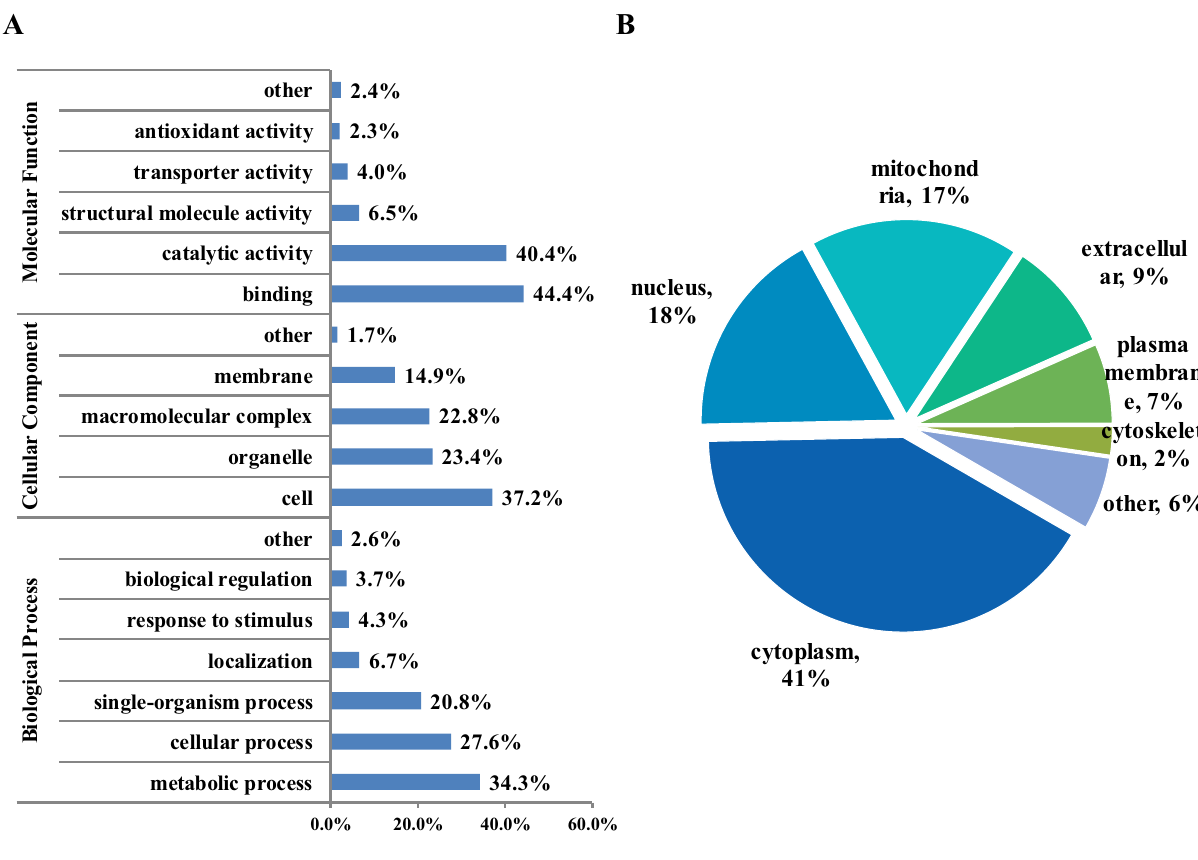
Figure 2. Functional classification and subcellular location analyses of the Khib proteins. ( A ) Function classification based on GO annotation. ( B ) Subcellular location from WoLF